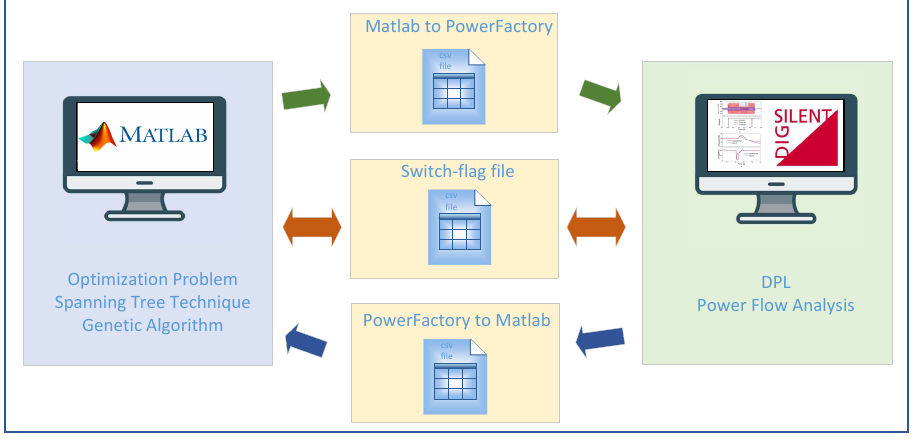
Figure 7. Peer-to-peer communication scheme between MATLAB and PowerFactory using csv